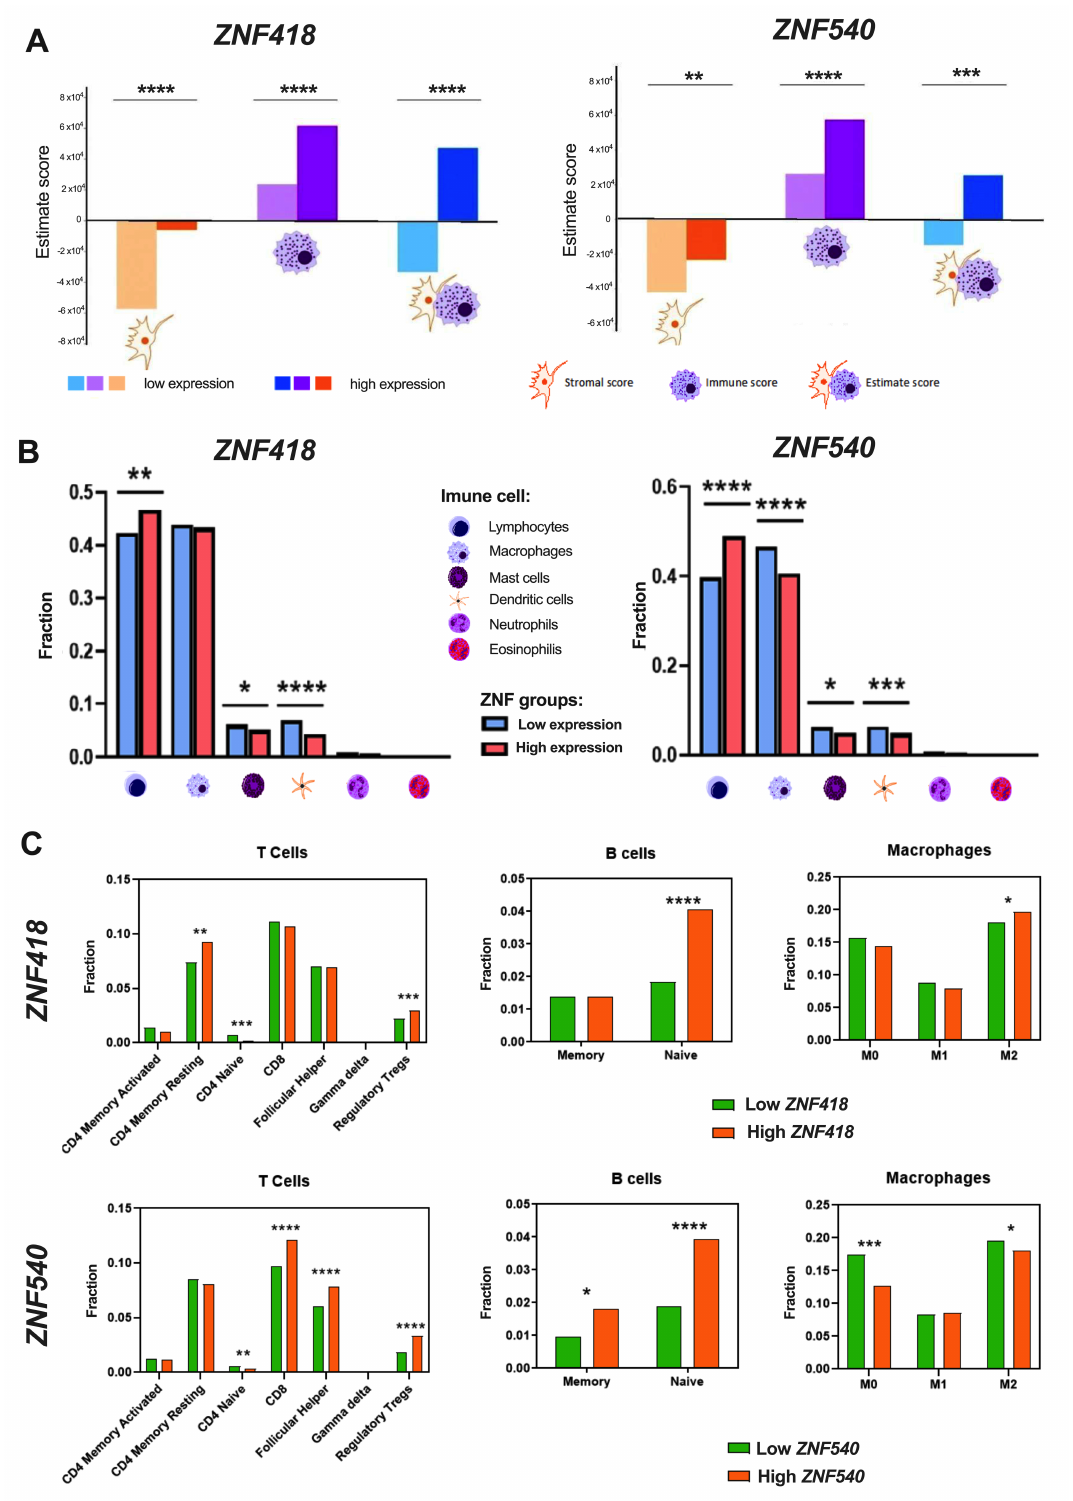
Figure 5. The immunological profile of HNSCC patients depends on the low and high levels of ZNF418 ( n Low = 271, n High = 250) and ZNF540 ( n Low = 261, n High = 260) genes. ( A ) Stromal, Immune, and ESTIMATE scores; ( B ) Infiltration of specific immune cells in tumor samples; ( C ) Differences in the fraction of T cells, B cells, and macrophages; t -test or Mann–Whitney U test; n —number of cases; ns —not significant; * p ≤ 0.05; ** p ≤ 0.01; *** p ≤ 0.001; **** p ≤ 0.0001 are considered